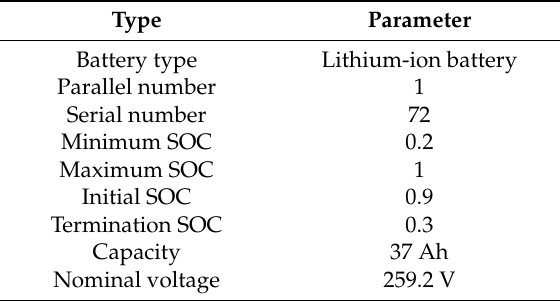
Table 2. Battery parameters. SOC: state of charge.